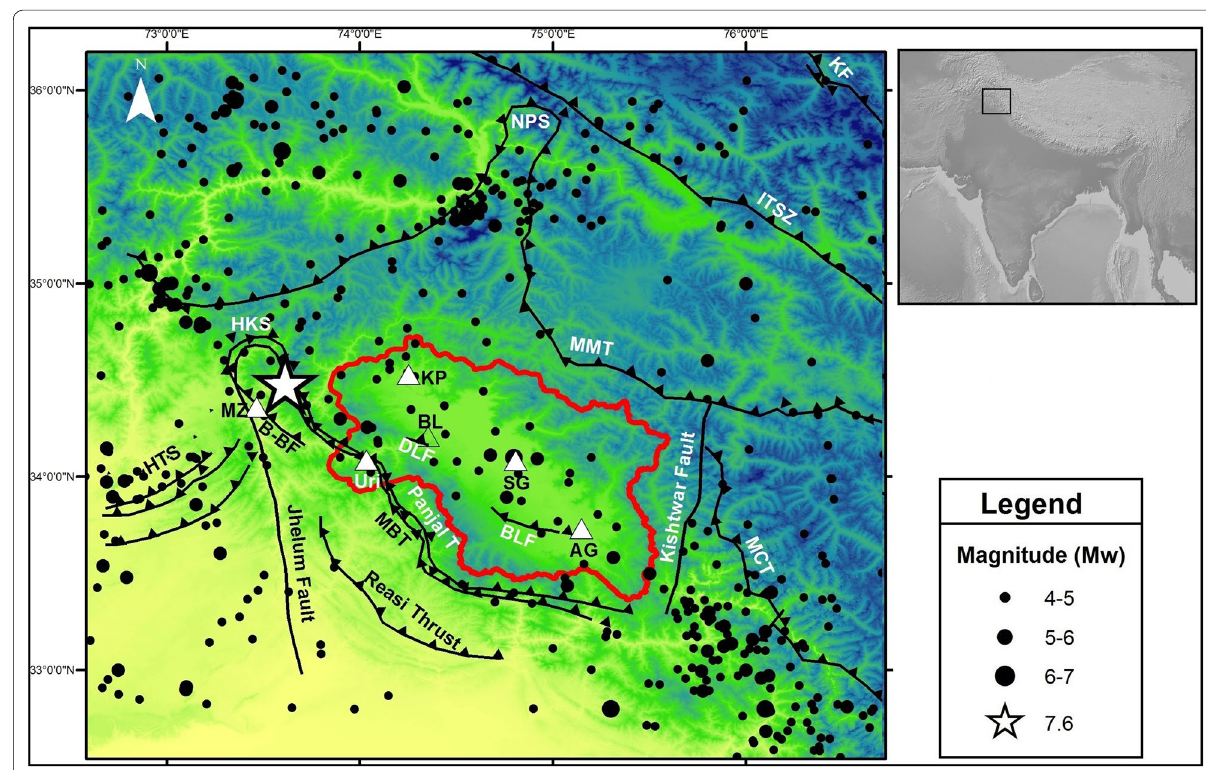
Fig. 1 Seismotectonic map of Kashmir Basin and surroundings with main tectonic features: Main Mantle Thrust (MMT), Main Crystalline Thrust (MCT), Main Boundary Thrust (MBT), Kishtwar Fault (KF), Panjal Thrust (PT), Reasi Thrust (RT), Jhelum Fault (JF), Bagh-Balakot Fault (B-BF), Hazara Thrust System (HTS), Balapur Fault (BF), Drangbal-Laridora Fault (DL), Hazara-Kashmir Syntaxis (HKS). Faults are from Dasgupta et al. (2000), BF from Ahmad et al. (2014) and DL from Sana and Nath (Sana and Nath 2016a, b). Star represents the epicenter of 8 October 2005 Kashmir earthquake ( M w